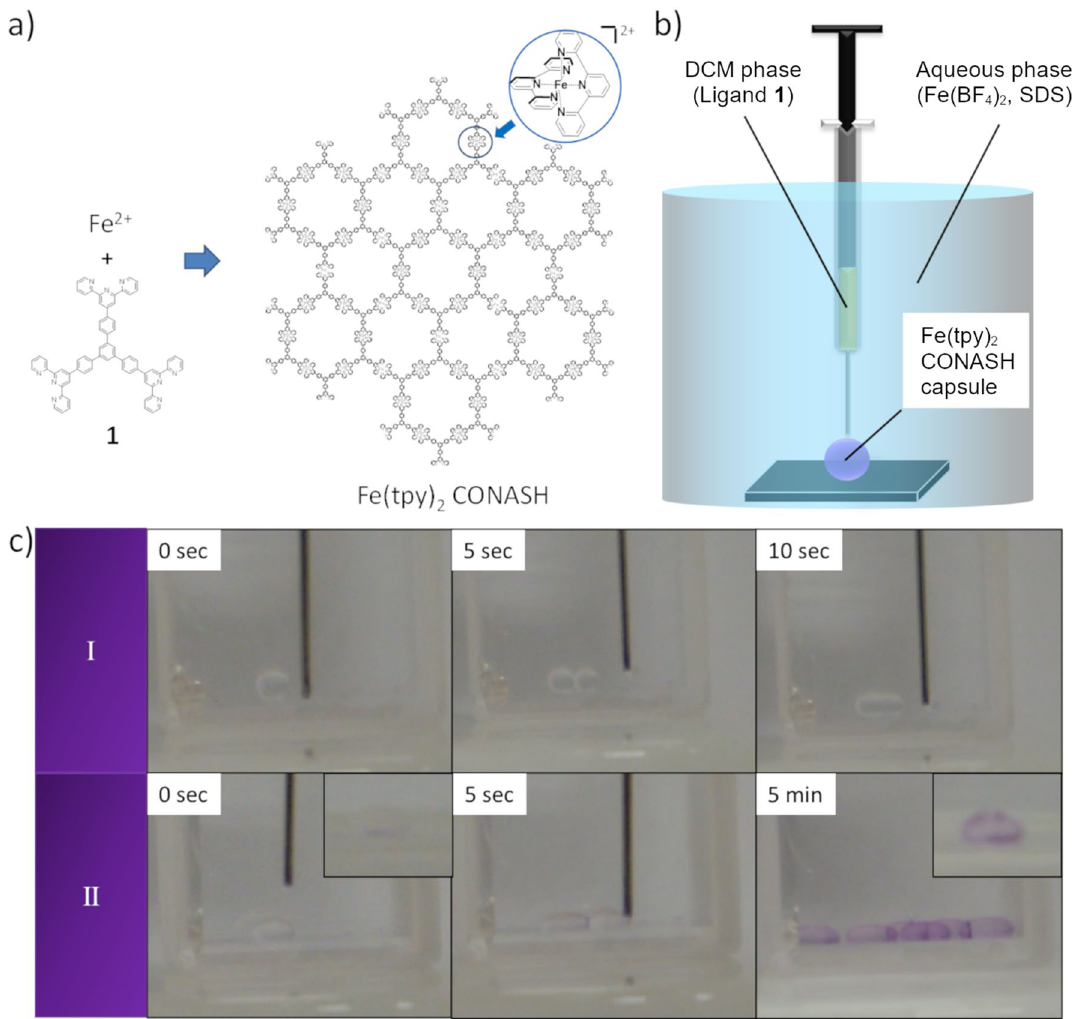
Figure 1. Dropping method to form Fe(tpy) 2 CONASH capsules. ( a ) Chemical structure of Fe(tpy) 2 CONASH. ( b ) Conceptual image of dropping method. ( c ) Snapshots of Fe(tpy) 2 CONASH capsules fabricated by dropping method, (I) in the absence of surfactant and (II) in the presence of